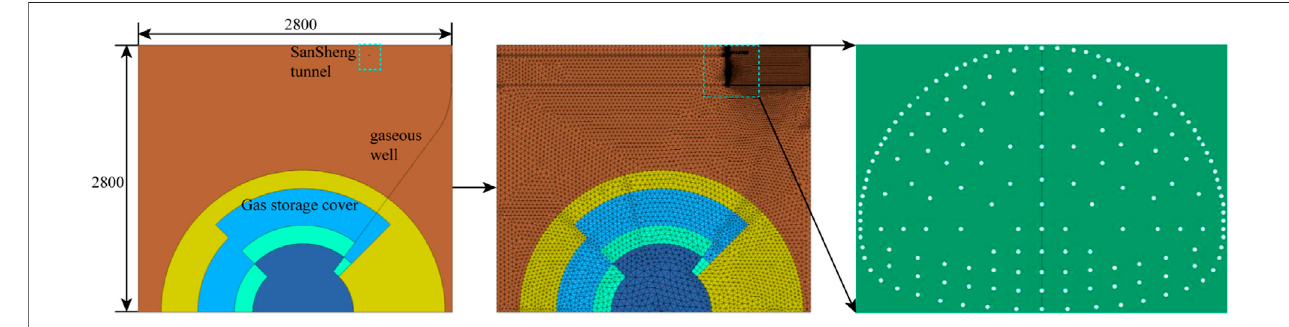
FIGURE 4 | Models and grids.